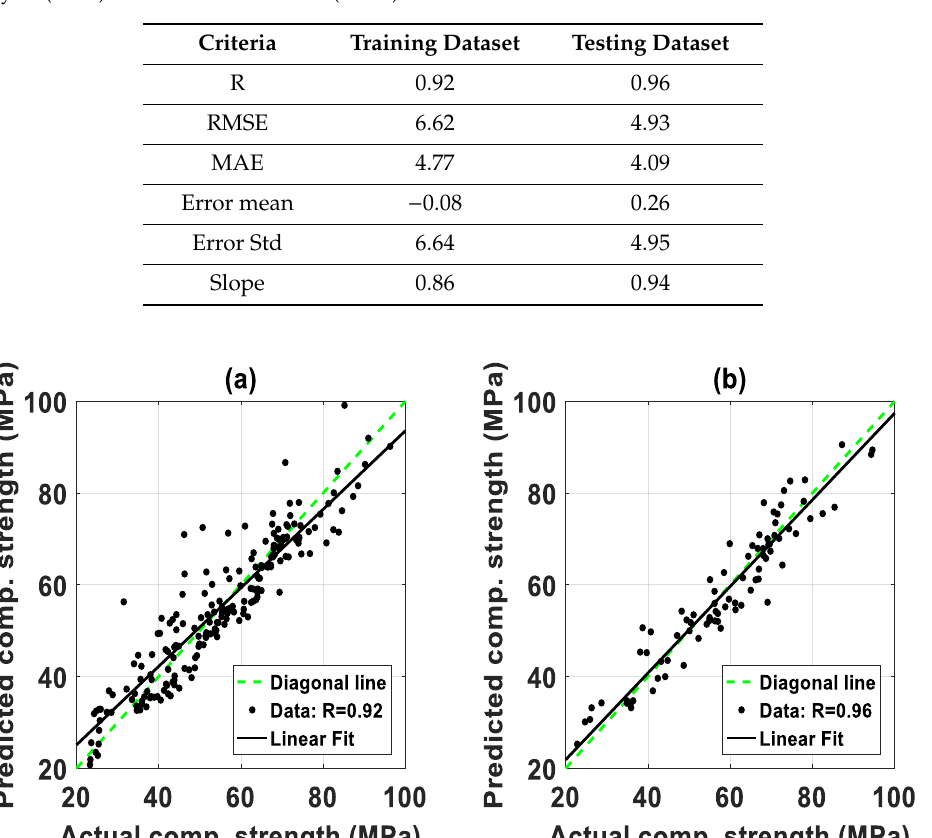
Table 3. Summary information of ANFIS-TLBO / P model after using PCA. Adaptive Neuro Fuzzy Inference System (ANFIS). Teaching-Learning-Based Optimization (TLBO). Principal Component Analysis (PCA). Mean Absolute Error (MAE).